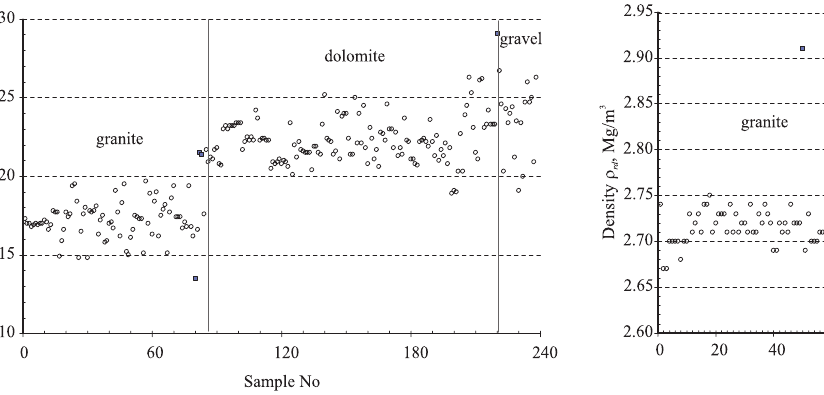
Fig. 4. ρ rd values of dry density of aggregate particles Fig. 3. SZ values of resistance to fragmentation of